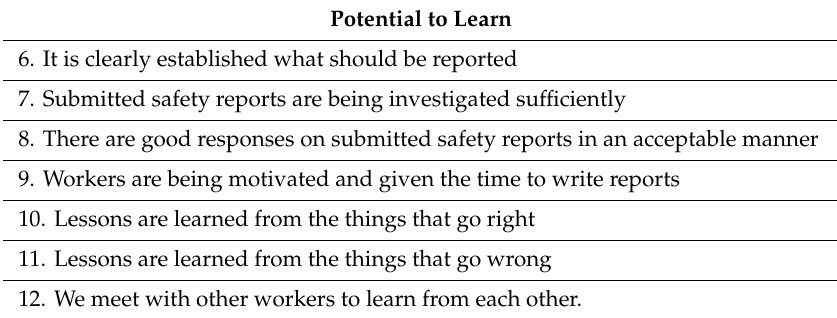
Table 2. Potential to Learn survey questions.